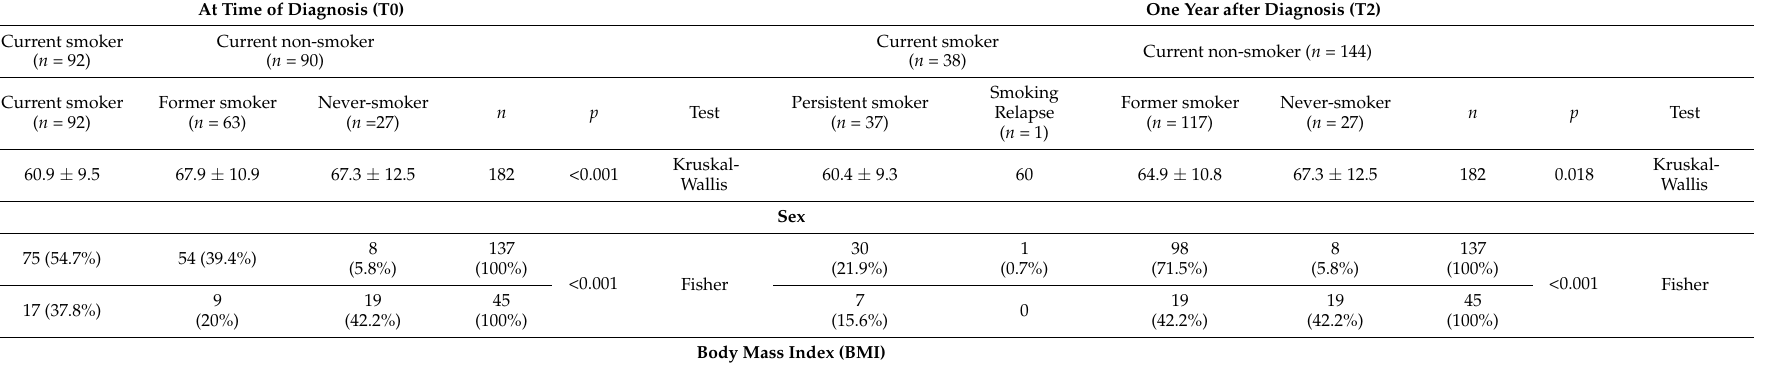
Table 1. Univariate analysis according to tobacco consumption. (Former drinkers were patients who no longer drank but had been drinking before data cutoff). At Time of Diagnosis